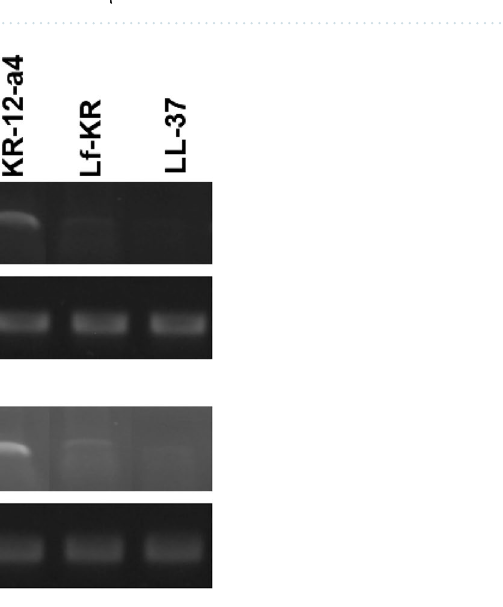
Figure 6. Effects of LfcinB6, KR-12-a5, Lf-KR, and LL ‐ 37 on the mRNA levels of iNOS and TNF-α in LPS- stimulated RAW264.7 cells. RAW264.7 cells (5 × 10 5 cells/well) were incubated with the peptides in the presence of LPS (20 ng/mL) for 3 h (for TNF-α) or 6 h (for iNOS). Total RNA was isolated and analyzed to determine the levels of iNOS and TNF-α mRNAs by